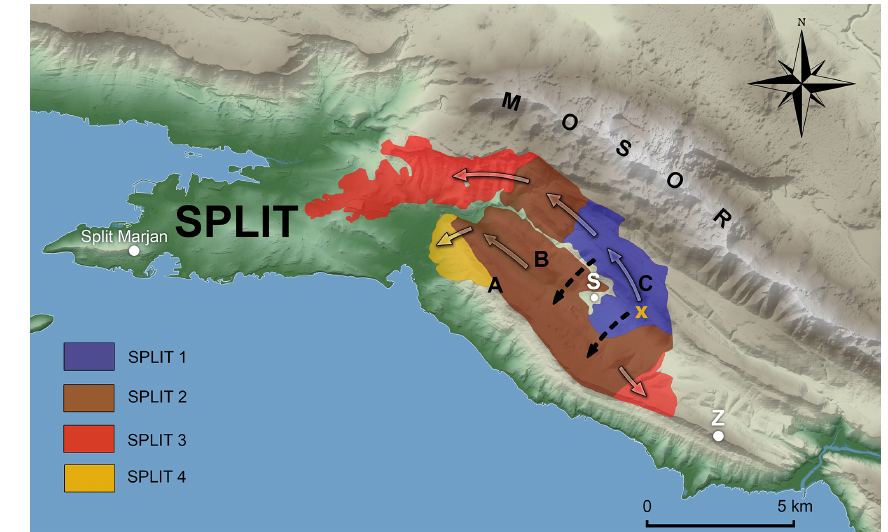
Figure 2. Map of the Split wildfire with the final perimeter and four prominent progressions in growth, noted as SPLIT 1 to SPLIT 4, over the first 30h from ignition (from 22:38UTC on 16 July 2017 to 04:00UTC on 18 July 2017). Ignition location is noted as X. White dots indicate locations of the Split-Marjan meteorological station, Zahod tower with cameras (noted as Z) used for fire detection and surveillance, the location of the village of Srinjine (noted as S). Split-Marjan and Srinjine are locations used for vertical profiles (pseudotemps). Letters indicate the hills Perun (A; 533ma.s.l.), Sridivica (B; 420ma.s.l.), and Makirina (C; 723ma.s.l.), all part of the Mosor (1339ma.s.l.) mountain range. (Basic topography from https://geoportal.dgu.hr/, last access: 18 August